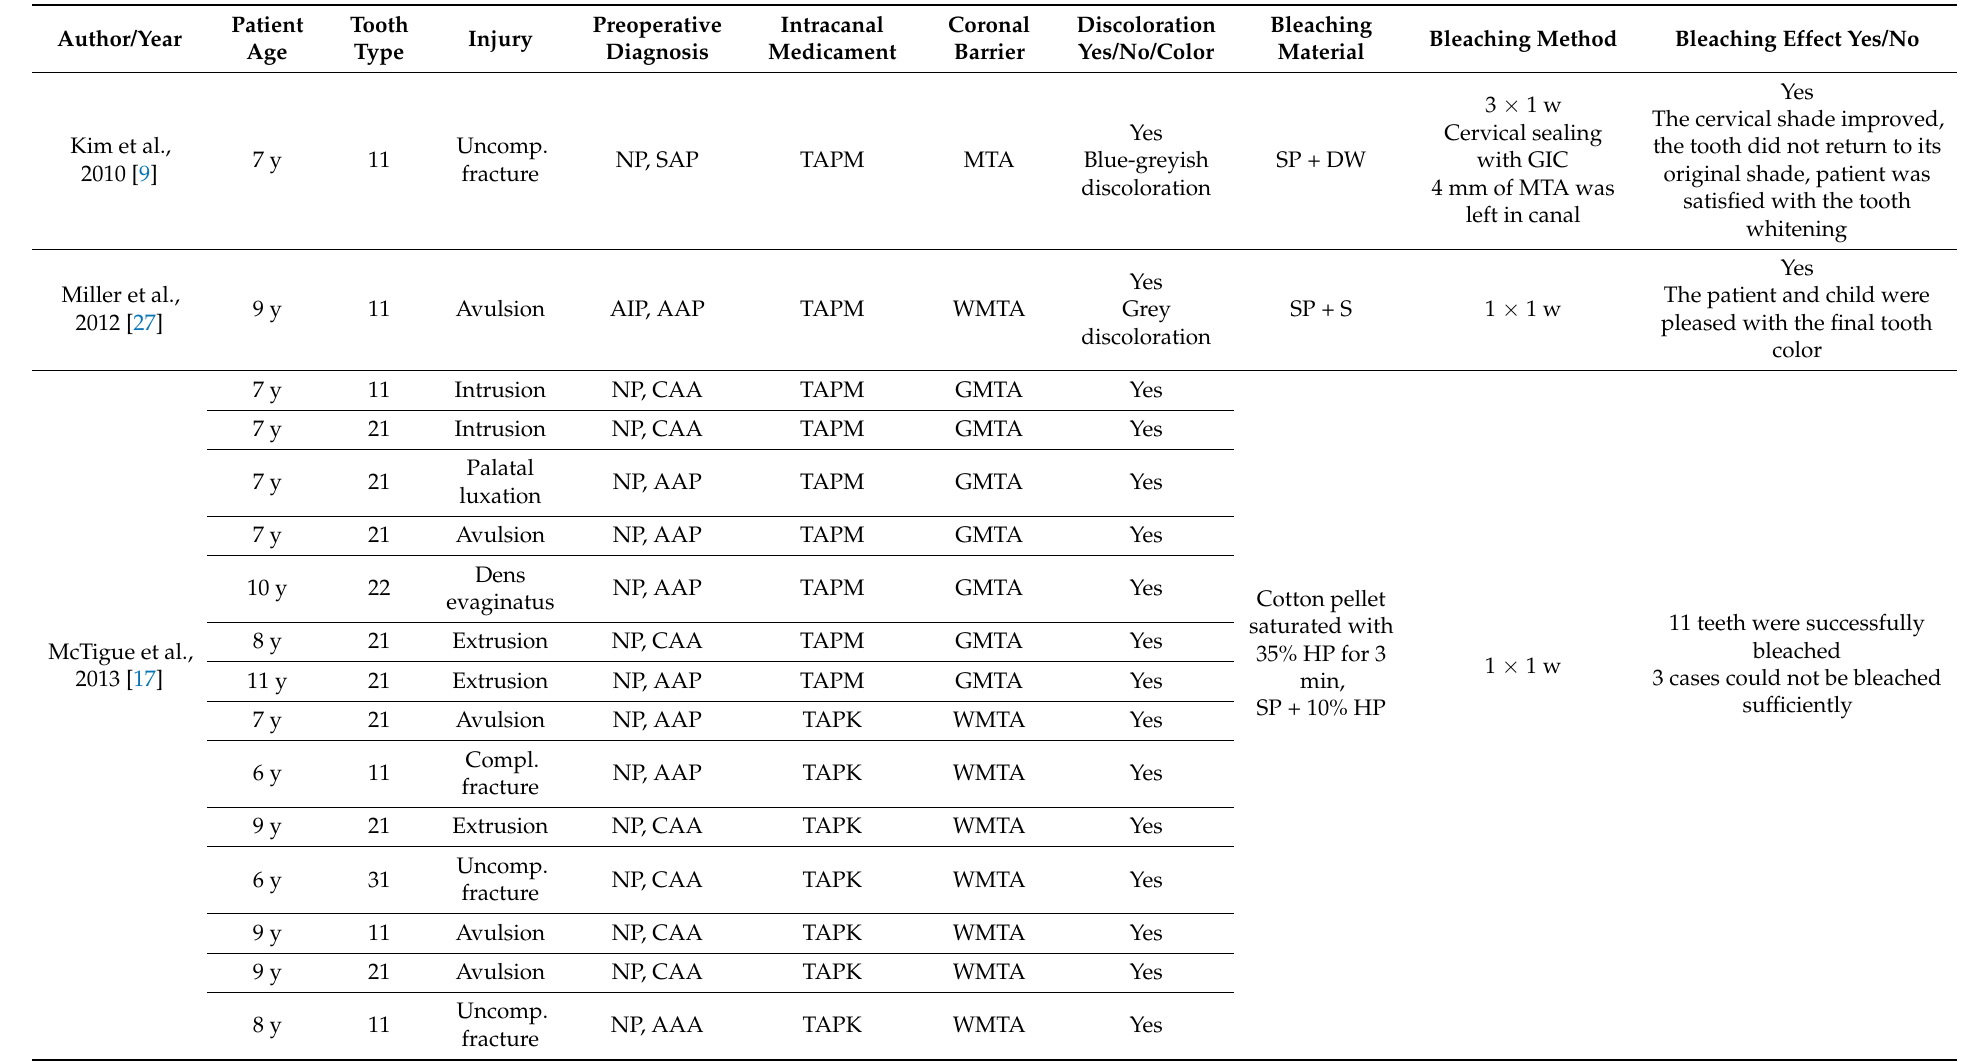
Table 5. Data pertaining to analyzed in vivo